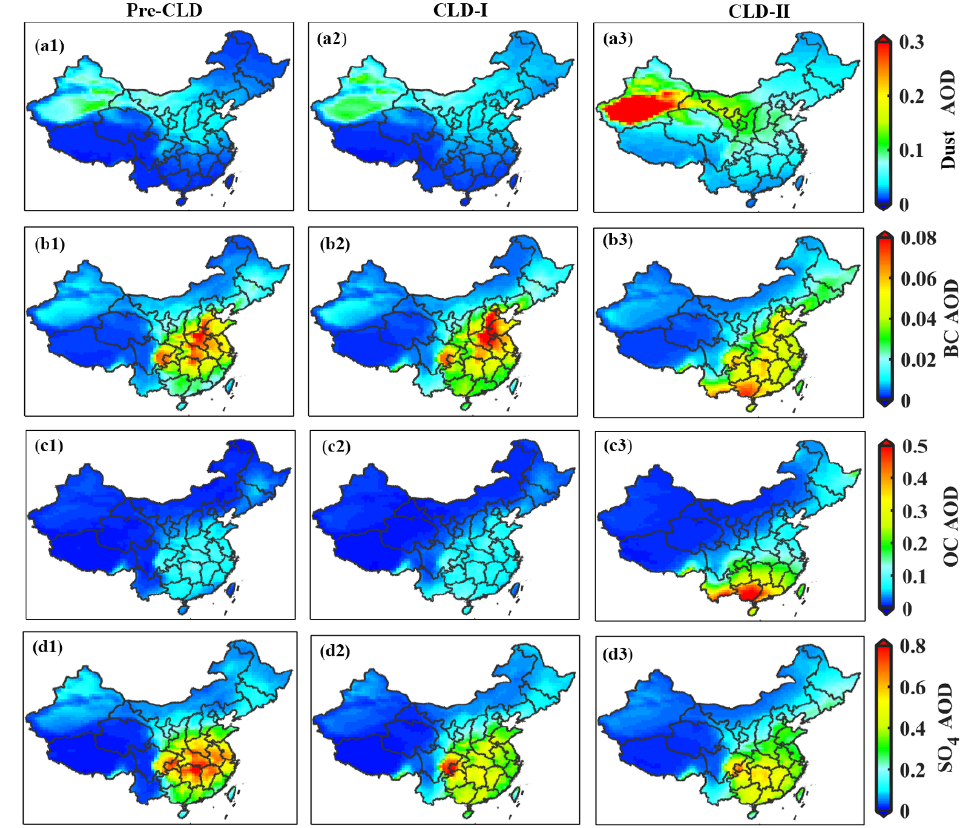
Figure 5. AOD of dust ( a1 – a3 ), BC ( b1 – b3 ), OC ( c1 – c3 ), and SO 4 ( d1 – d3 ) from MERRA-2 during the Pre-CLD, CLD-I, and CLD-II periods. The study area’s boundaries and the locations of key cities were shown in Figure